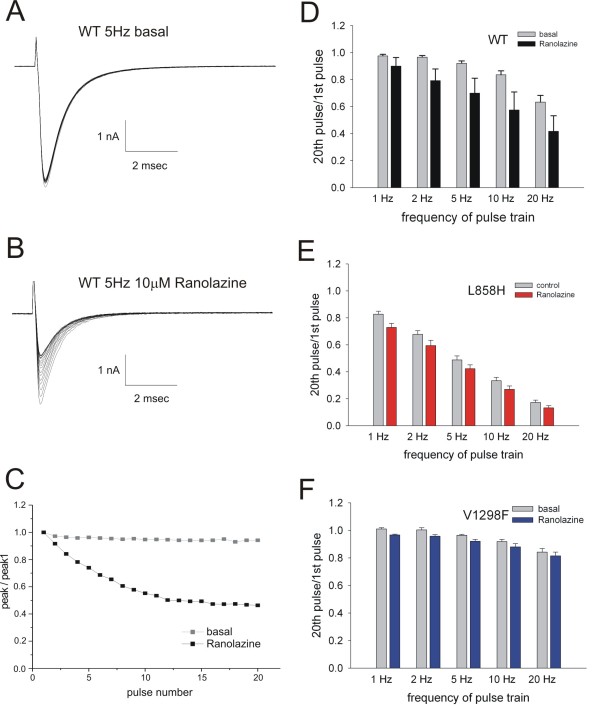
Frequency-dependence of use-dependent block of Nav1.7 currents by ranolazine. Trains of twenty 30 msec duration pulses to -10 mV from a holding potential of -120 mV were applied at five different frequencies and were performed both before and after exposure to 10 μM ranolazine. Example traces from a HEK 293 cell expressing WT channels are shown in panels A and B. The peak for each pulse is normalized to the peak of the first pulse, and the values are plotted in panel C. The use-dependent block, defined as the ratio of the peak from the 20th pulse normalized to the peak of the first pulse, was determined for each cell and the averages are plotted with the basal responses shown in grey and the ranolazine responses shown in solid bars. In each panel the two datasets are shown to compare the response to ranolazine in cells expressing WT (panel D, n = 5), the IEM mutant L858H (panel E, n = 4), or the PEPD mutant V1298F (panel F, n = 7), channels.